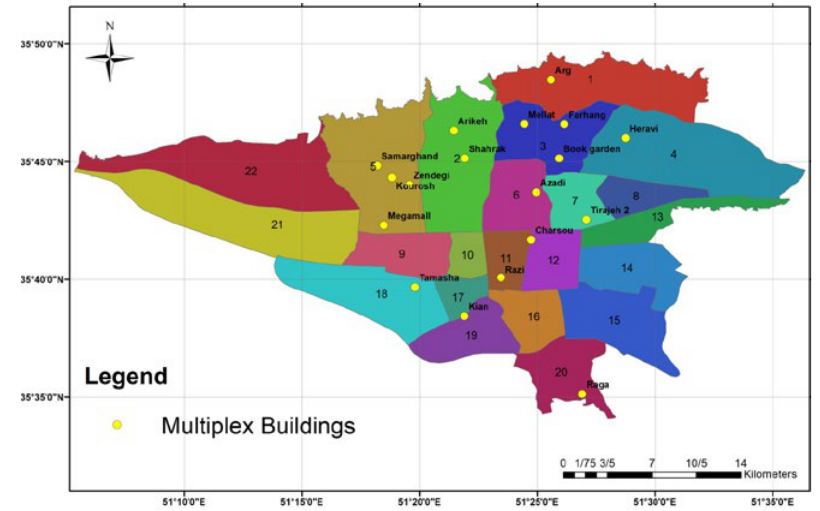
Fig. 1: Distribution map of multiplex buildings in 22 districts of Tehran